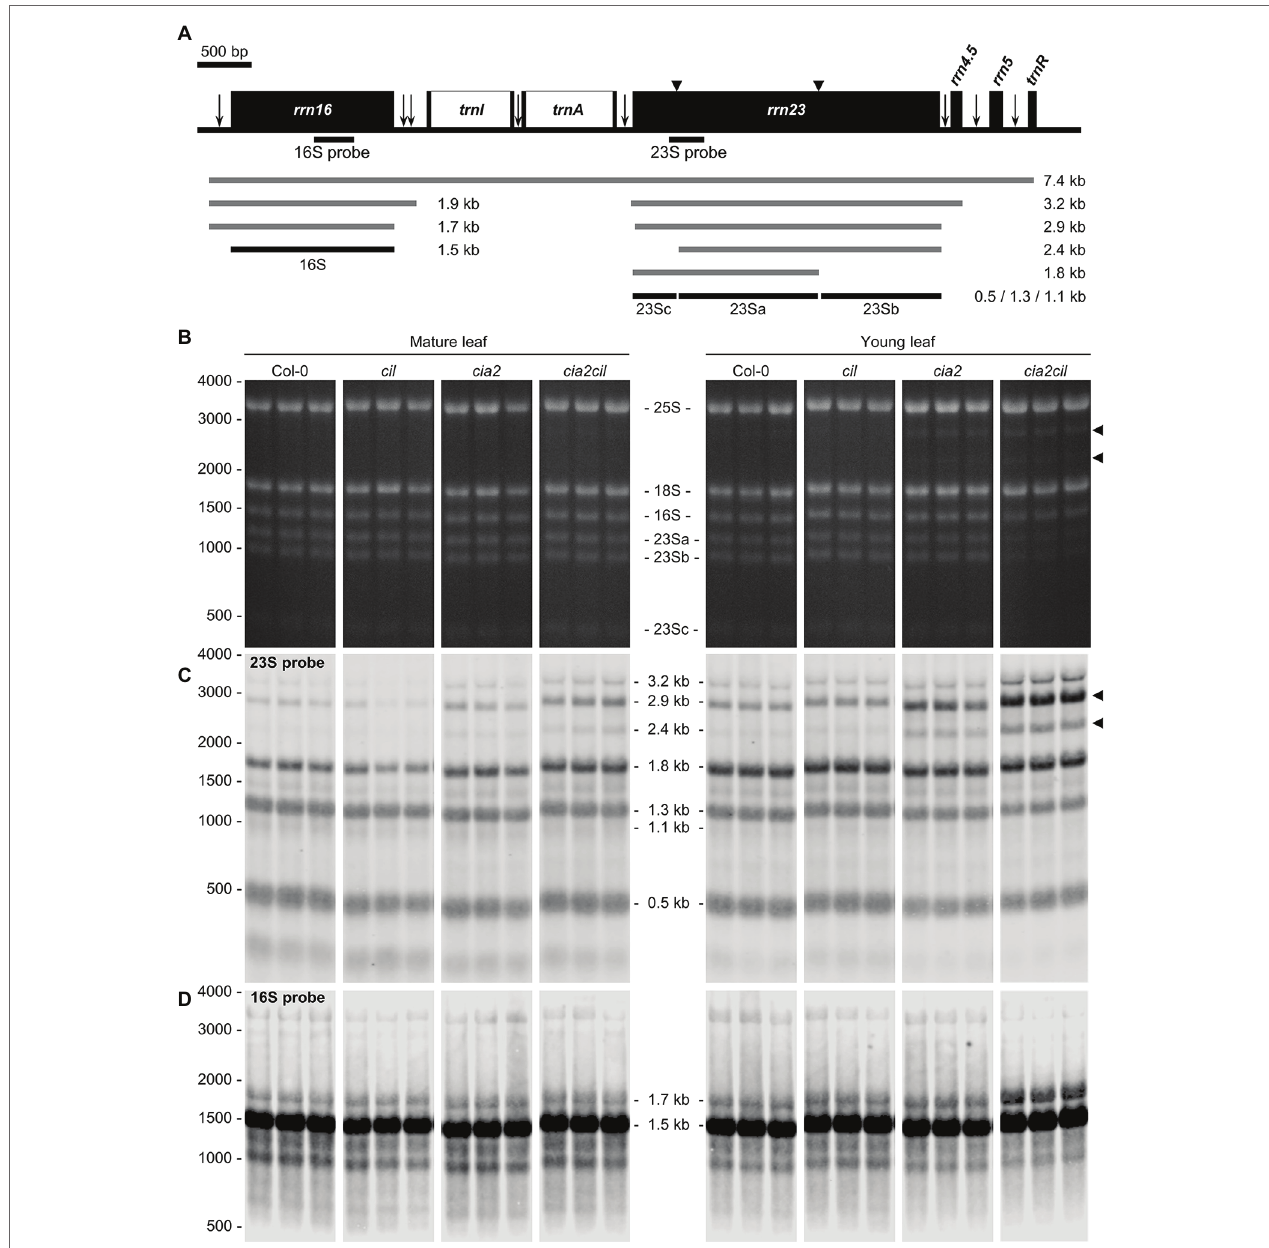
FIGURE 6 | Analysis of chloroplast rRNA processing in Col-0, cil , cia2 , and cia2cil mutant plants. (A) Structure and transcript pattern of the chloroplast rrn operon. Black boxes indicate exons and white boxes indicate introns. Vertical arrows indicate processing sites in the primary transcripts of the rrn operon. Positions of internal cleavage sites (hidden breaks) in the 23S rRNA are shown as black triangles. Positions of the hybridization probes for 16S and 23S are indicated below the operon structure. The 7.4-kb primary transcript and various processing precursors are shown with gray lines; the mature forms of 16S and 23S rRNAs are shown with black lines. The Arabidopsis chloroplast genome (GenBank accession number: NC000932.1) was used as reference. (B) Separation of cytosolic and chloroplastic rRNAs on agarose gel. The 23Sa, 23Sb, and 23Sc bands represent 1.3, 1.1, and 0.5 kb mature forms of 23S rRNA, respectively. Each sample with three biological replicates. Arrows indicate intermediates of inefficient processing of the 23S rRNA. (C) Analysis of 23S rRNA processing by RNA gel-blot hybridization. Arrows indicate pre-mature 23S rRNA species shown in panel (B) . (D) Analysis of 16S rRNA processing by RNA gel-blot hybridization. The original gel images are provided as Supplementary Figure 4